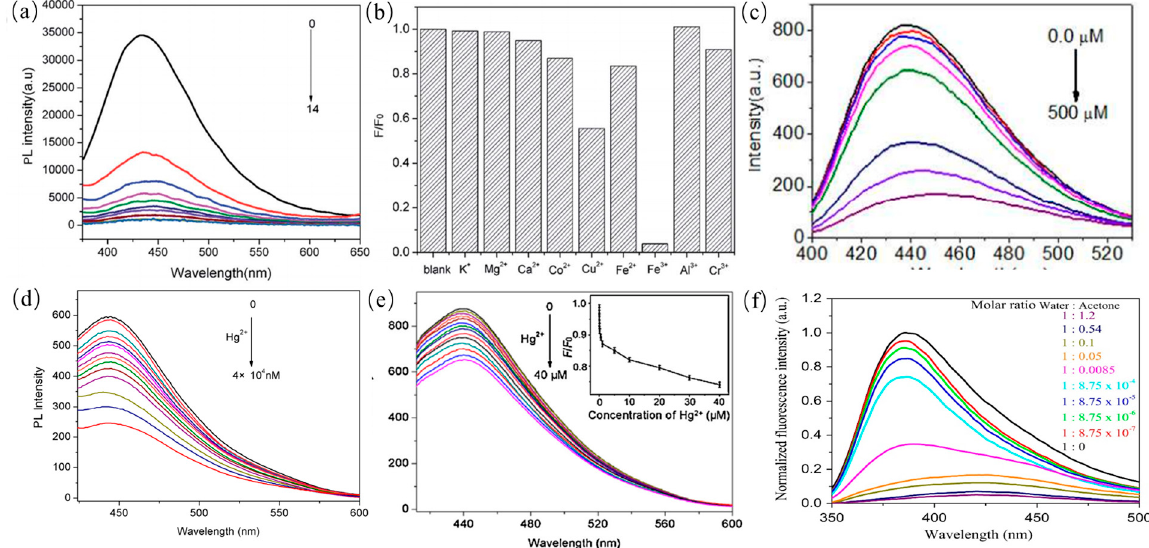
Figure 18. ( a ) The PL emission of S-CDs for detection of Fe 3+ ions at different concentrations, and ( b ) The bar chart of the responses of S-CQDs [143]. Copyright 2015, Royal Society of Chemistry. ( c ) PL emission of CDs for detection of Fe 3+ ions